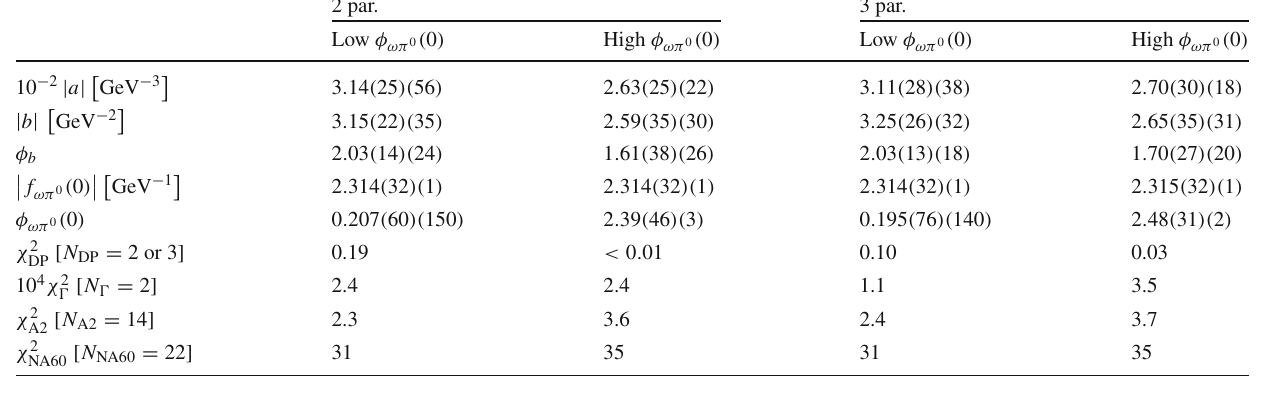
Fig. 5 Real (left) and imaginary (right) parts of the function F ( s ) (modulo | a | ) [cf. Eq. (2.22)], with b = | b | e φ b as in Table 2, case “3 par.”. We show the results for the “low φ ( 0 ) ” (blue solid) and “high ωπ 0 φ ( 0 ) ” (red dash-dotted) ωπ 0 solutions. The error bands are obtained from a MC analysis of the fitted data, and represent the correlated 1 σ uncertainty in our